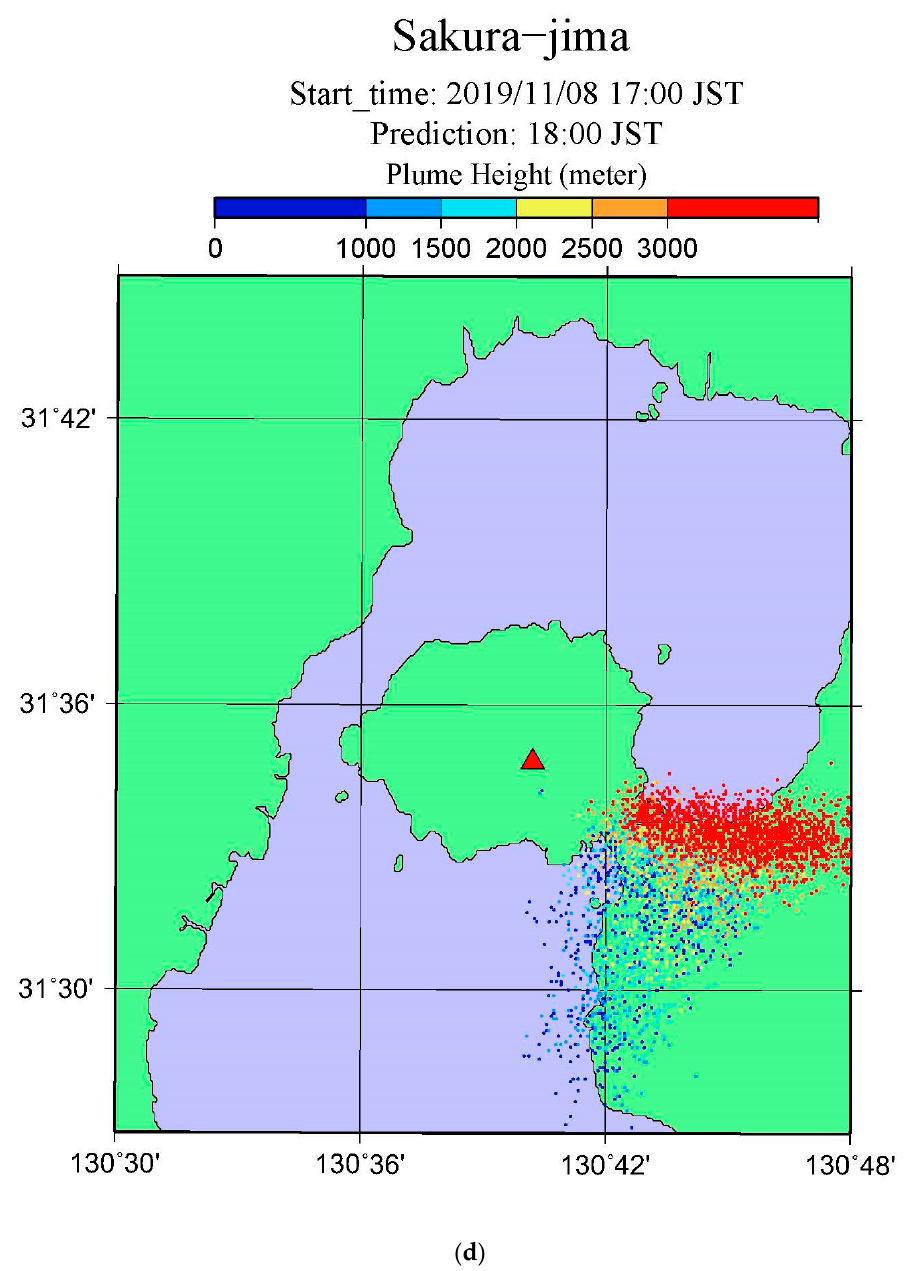
Figure 8. PUFF model simulation as in Figure 3, but using the MP radar data for ( a ) 17:30, ( b ) 17:40, ( c ) 17:50, and ( d ) 18:00 JST, respectively.